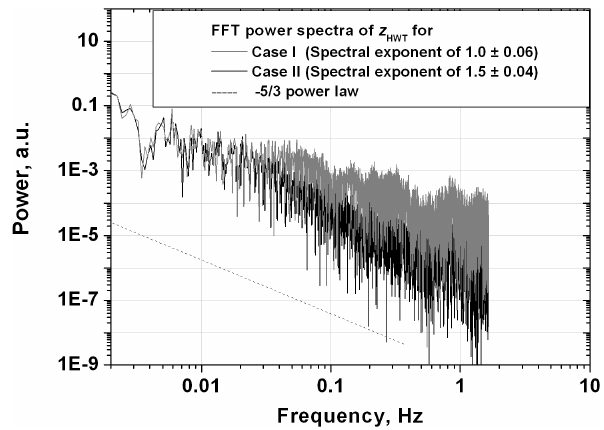
Fig. 15. FFT power spectra of the time series of z HWT obtained for Case I (gray line) and Case II (black solid line). The − 5/3 power law curve is shown for comparison. A spectral exponent value of 1.00 ± 0.06 and 1.50 ± 0.04 are found for Case I and Case II, respec-